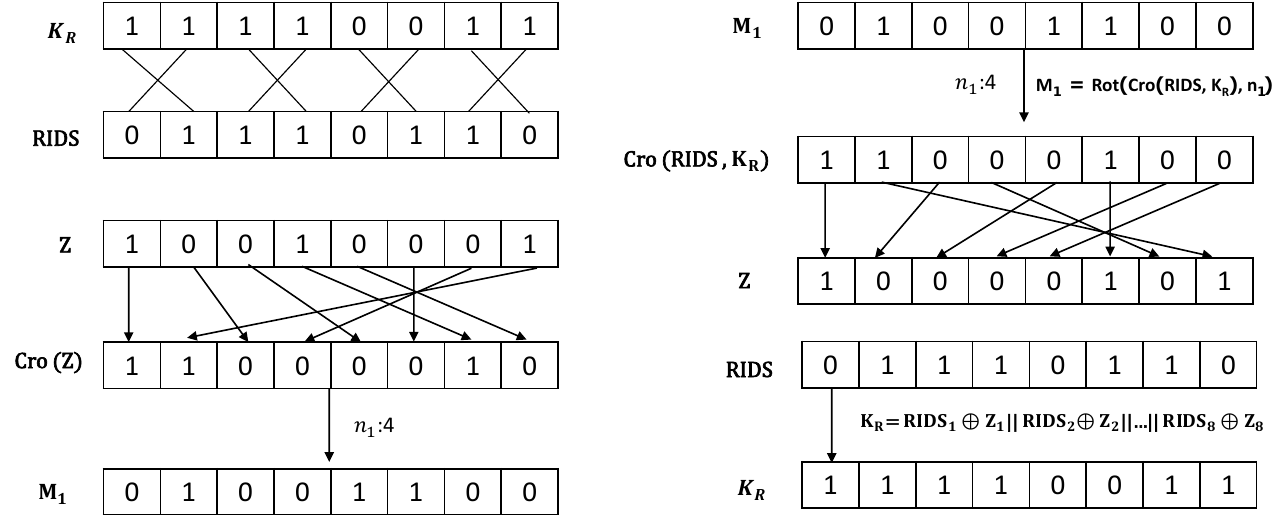
Figure 3. An example for proposed secret disclosure attack against